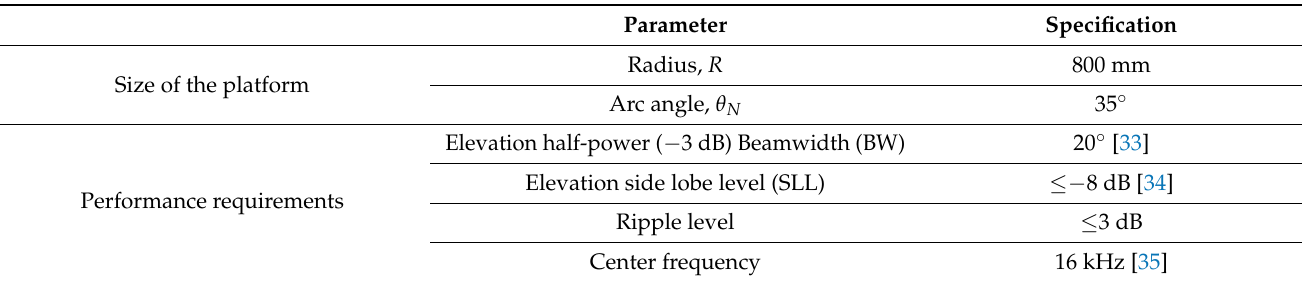
Table 1. Specifications for a design case